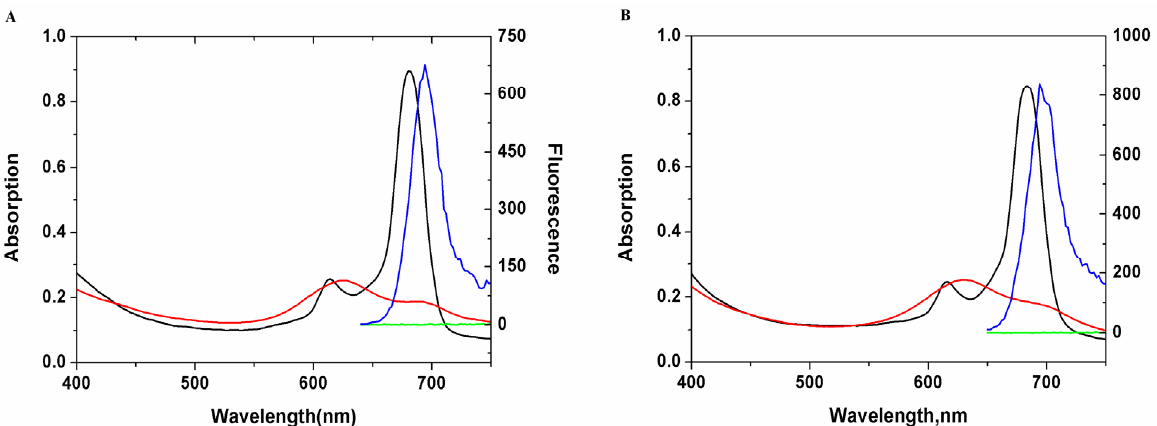
Figure 3. Absorption spectrum and fluorescence spectrum of saccharide substituted zinc phthalocyanines in DMSO (Abs: in black; FL: in blue) or water solution. (Abs: in red, FL: in green) ( A ) glucose substituted zinc phthalocyanine; ( B ) lactose substituted zinc